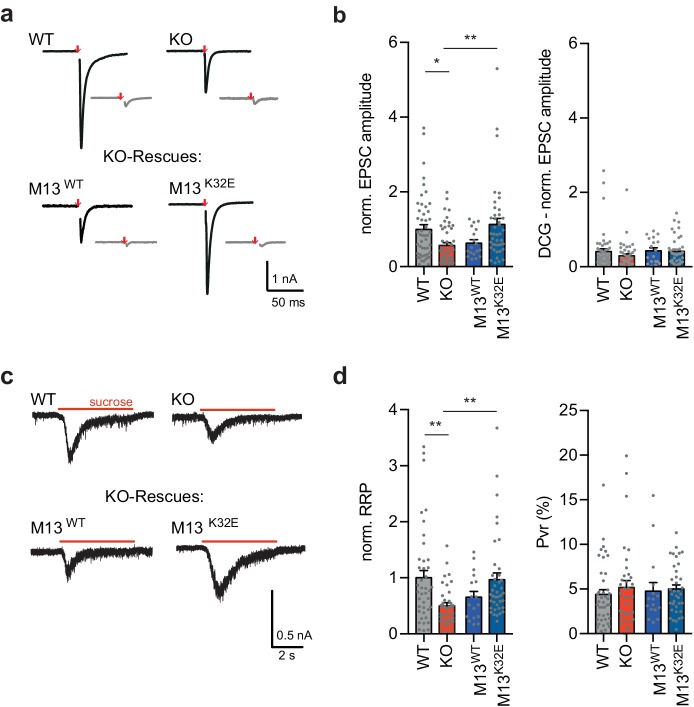
Monomeric Munc13-1 rescues vesicle priming in RIM-BP2 KO granule autaptic neurons.(a) Sample traces of evoked EPSC amplitudes before (black) and after DCG IV application (gray) for RIM-BP2 WT and KO neurons and lentiviral-transduced RIM-BP2 KO rescues with either Munc13-1 WT (M13WT) or Munc13-1 K32E (M13K32E). (b) Summary graphs of normalized EPSC amplitudes evoked by 2 ms depolarization (red arrow) (EPSC WT (49/3); KO (47/3); M13WT (18/2); M13K32E(41/3)) and after DCGIV application. (EPSC-DCG WT (49/3); KO (44/3); M13WT (18/2); M13K32E(41/3)) (c) Sample traces and (d) summary graphs of normalized RRP responses elicited by a 5 s application of 500 mM sucrose (RRP WT (41/3); KO (36/3); M13WT (17/2); M13K32E(39/3)). Summary graph of the PVR calculated as the ratio of the EPSC charge and the RRP charge (Pvr WT (41/3); KO (38/3); M13WT (16/2); M13K32E(37/3)). Values represent mean ± SEM. *p<0.05, **p<0.01. For statistics please see Figure 6—source data 1.10.7554/eLife.43243.026Figure 6—source data 1.Statistics of data presented in Figure 6.